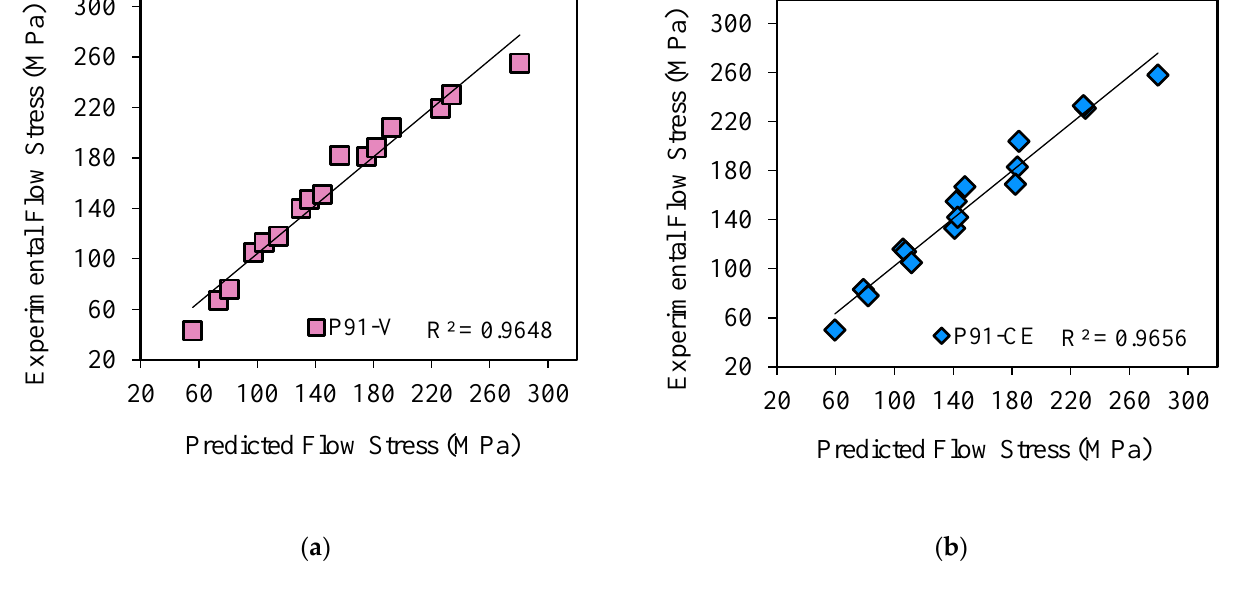
Figure 10. Prediction of flow stress of mathematical models for ( a ) steel A and ( b ) steel B .